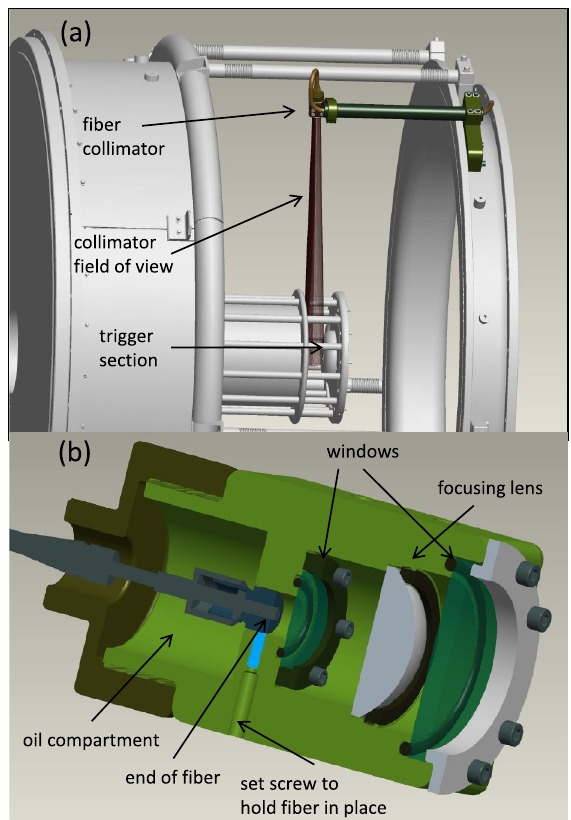
FIG. 4. (a) Location of the LSD collimator with respect to the trigger gap. One can see that only the trigger section is within the field of view of the collimator. The ‘‘collimator field of view’’ in the figure represents the solid angle that the fiber collimator can ‘‘see.’’ (b) Optical collimator assembly: The 30 mm diameter, 35 mm focal length lens is located in an air filled chamber that is sealed with a window on each side (40 and 19 mm diameter). The fiber tip itself is located in an oil filled chamber.